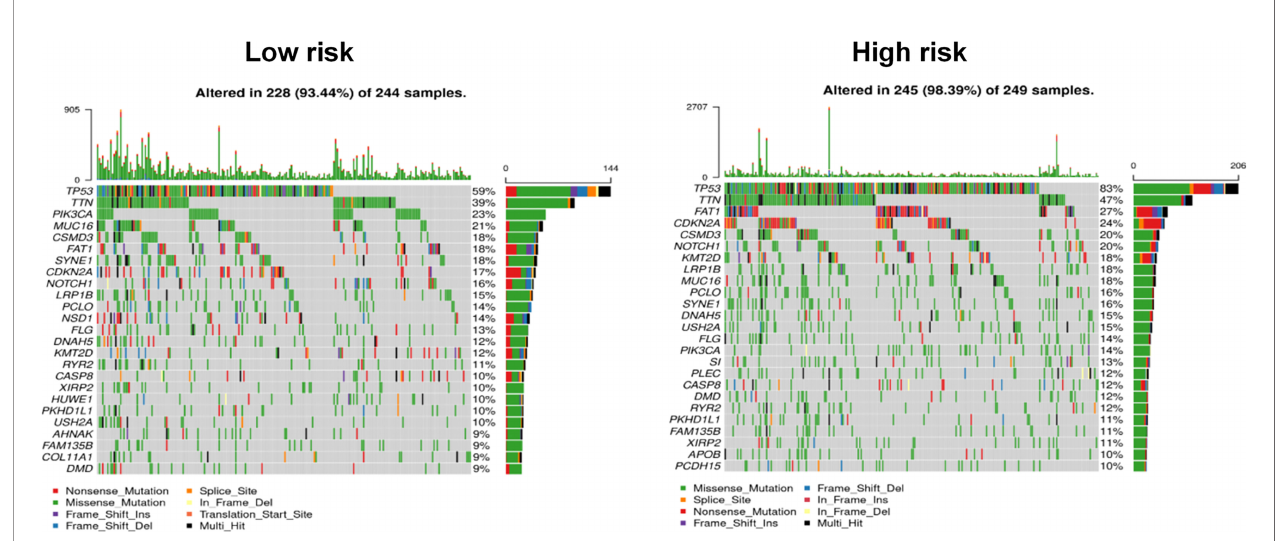
FIGURE 7 | Comparison of mutational differences between high- and low-risk